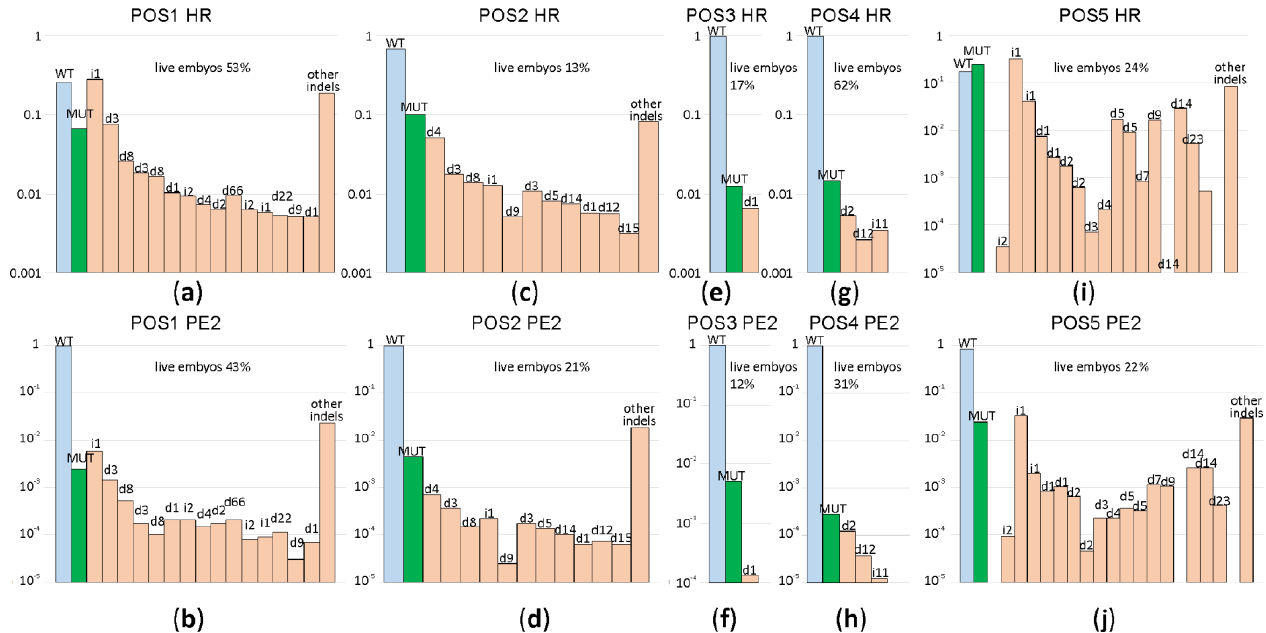
Figure 2. Comparison of genome editing efficiencies for ssDNA guided HR and PE2 assessed for a set of genome regions 1–5. Shown are frequencies of allelic variants, in the logarithmic scale, detected in the blastocysts developed from the zygotes after microinjection. Blue bars correspond to the wild type genotype, green to the mutation programmed by a template, while pale red to insertions and deletions. Allelic variants are designated above the bars. Panels ( a , c , e , g , i ) correspond to ssDNA guided HR, while panels ( b , d , f , h , j ) to PE2 driven genome editing. Panels ( a , b ) correspond to genome position 1, ( c , d ) to genome position 2, ( e , f ) to genome position 3, ( g , h ) to genome position 4, while ( i , j ) corresponds to genome position 5. For each construct, the percentage of zygotes developed to the blastocyst or morula stage is indicated above the graph.